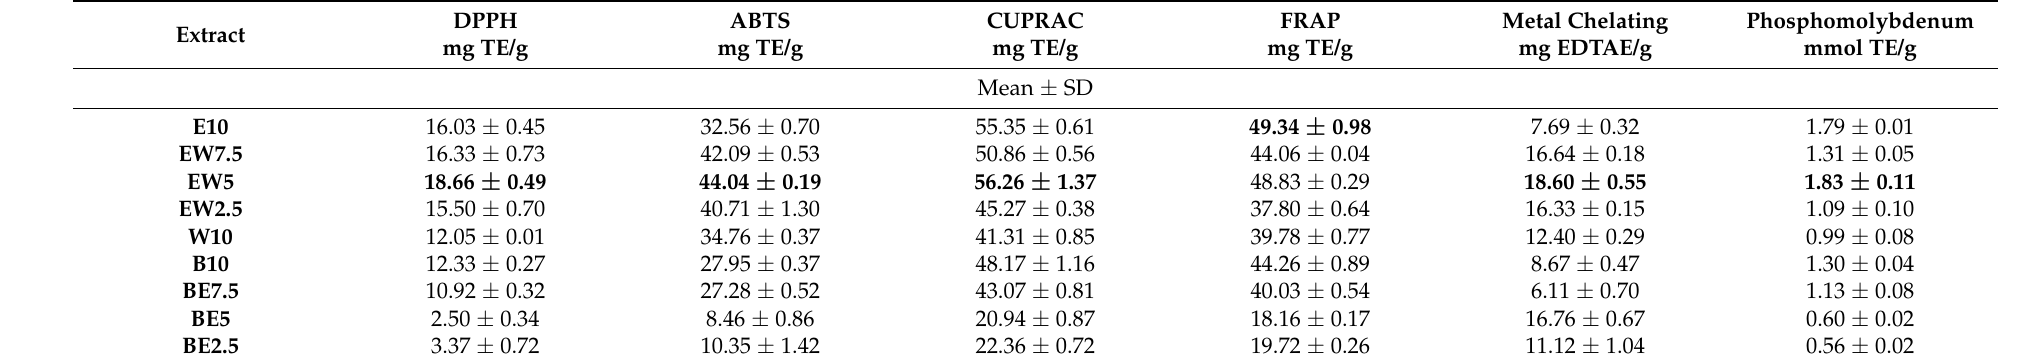
Table 9. Antioxidant activity of different Allium scrorodoprasum flower extracts.